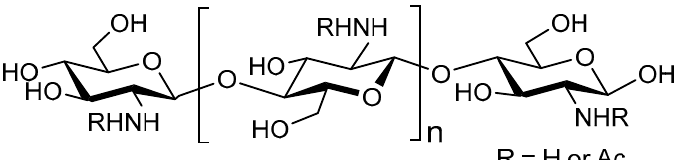
Figure 3. Structure of the main components of COS; with the monosaccharides N-acetylglucosamine (GlcN) and GlcNAc.